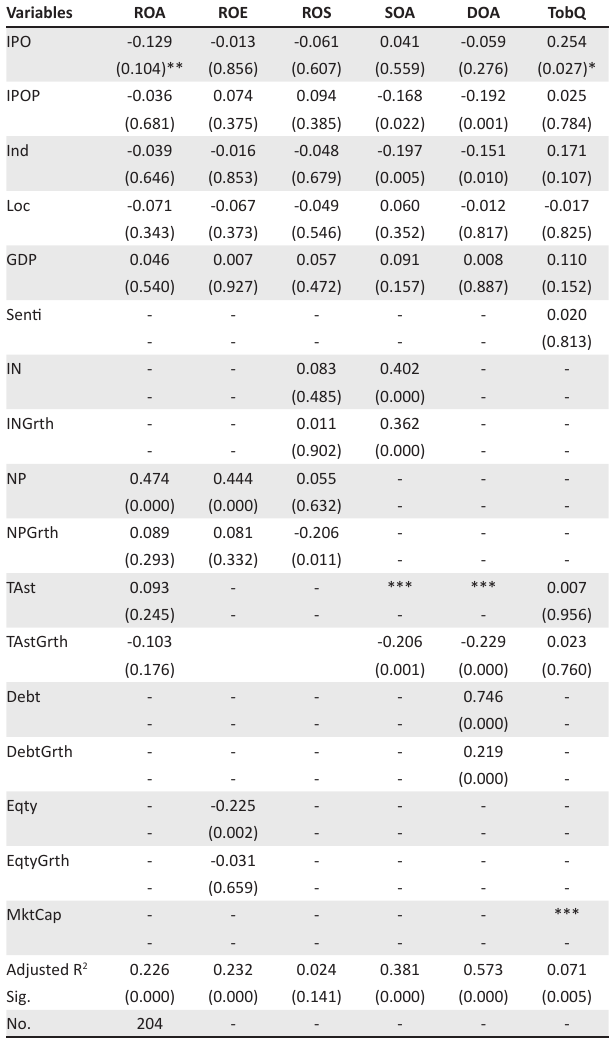
TABLE 8: Estimation results of multiple regressions of firms’ performance indicators on IPO and other explanatory variables.